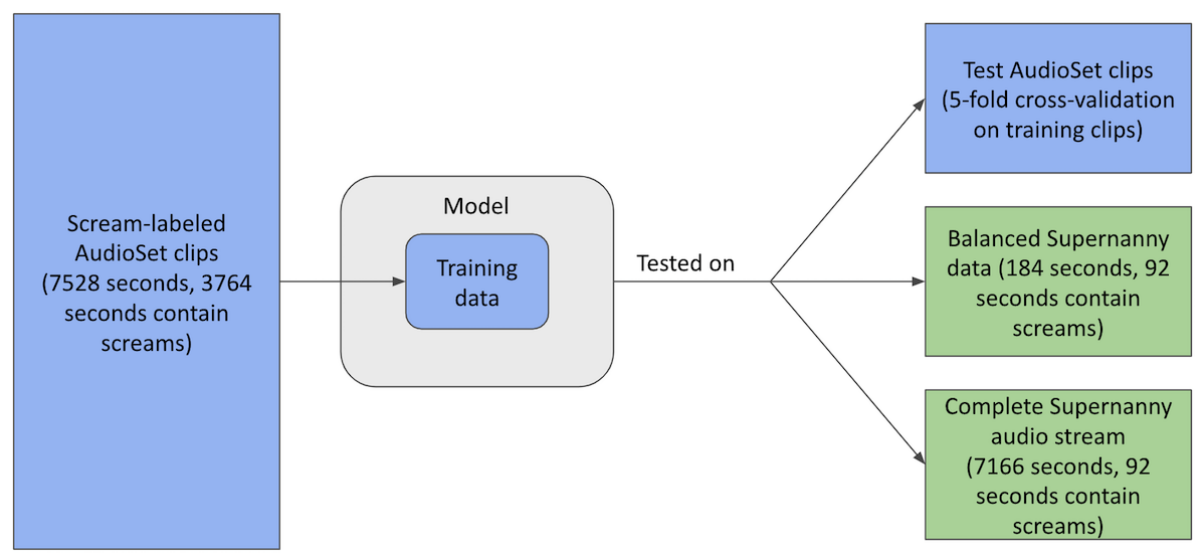
Figure 1. Study design. The model was built using the AudioSet clips by standard 5-fold cross-validation. The model was then tested on Supernanny data for transferability.